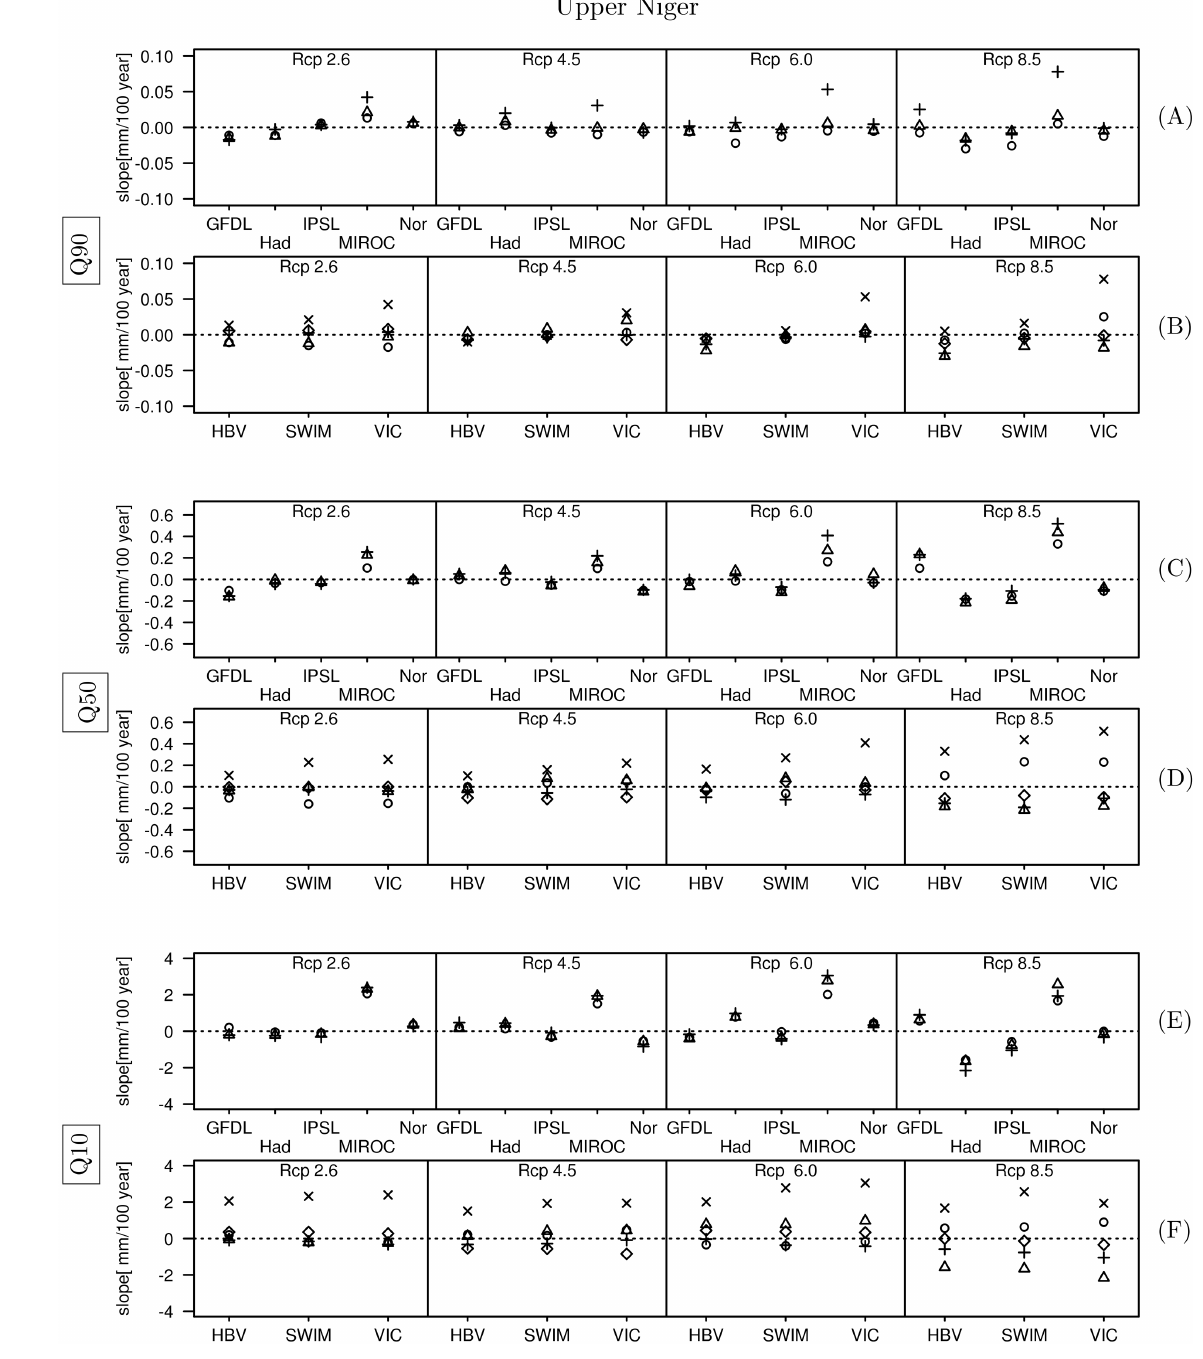
Figure A1. Slopes of trends in (a, b) low-flow percentile Q 90 , (c, d) medium discharge Q 50 and (e, f) high-flow percentile Q 10 grouped by climate models (a, c, e) and by hydrological models (b, d, f) for the Upper Niger.